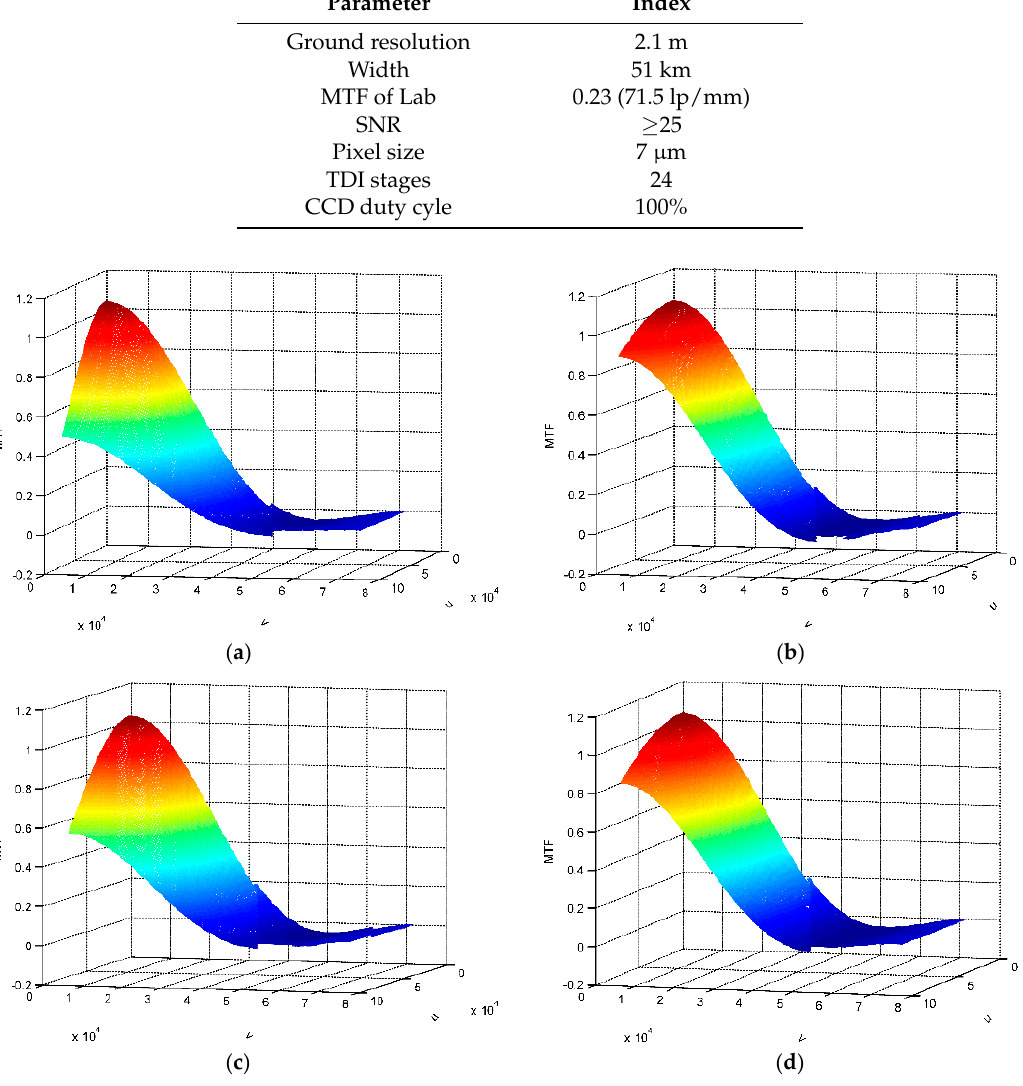
Table 1. Key technical parameters of the ZY-3 satellite nadir camera.